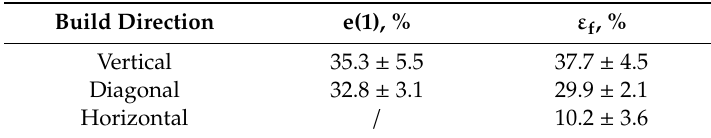
Table 4. Fracture strain immediately prior to fracture determined with DIC (e(1)) and analytically determined with digital microscopy ( ε f ).